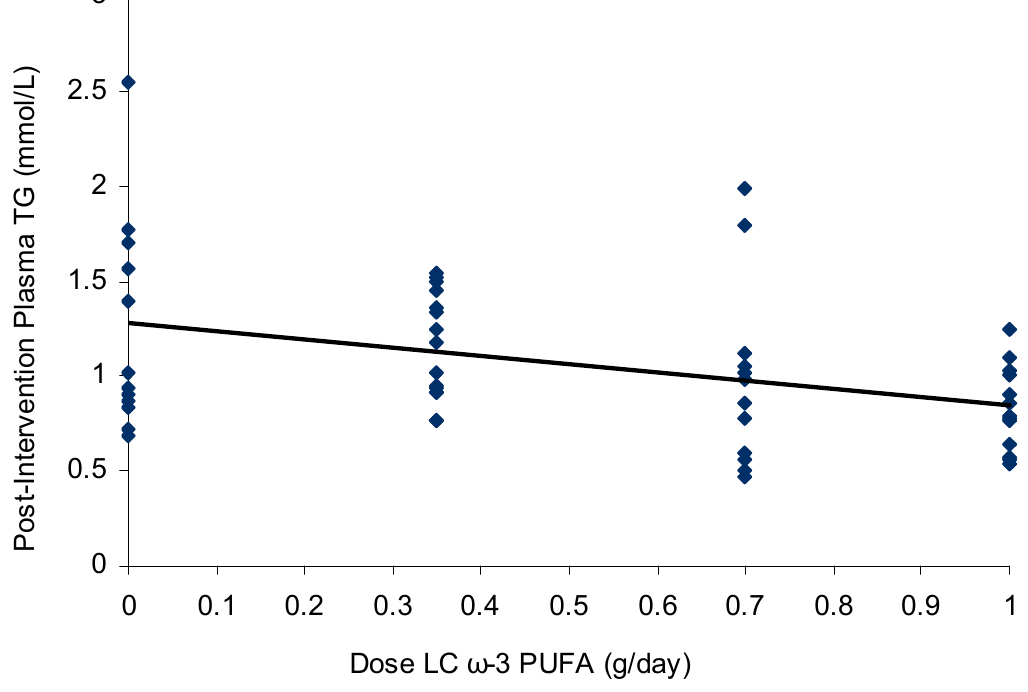
Figure 3. Scatterplot (with linear regression line) of plasma triglyceride levels (mmol/L) following supplementation with 0, 0.35, 0.7, and 1 g/day n -3 LCPUFA from HiDHA™ tuna oil ( n = 53). R 2 = 0.16, p = 0.003 in the per-protocol analysis. 0 g/day group n = 12; 0.35 g/day group n = 15; 0.7 g/day group n = 13; 1.0 g/day group n = 13.